Question: Produce a descriptive caption suitable for publication.
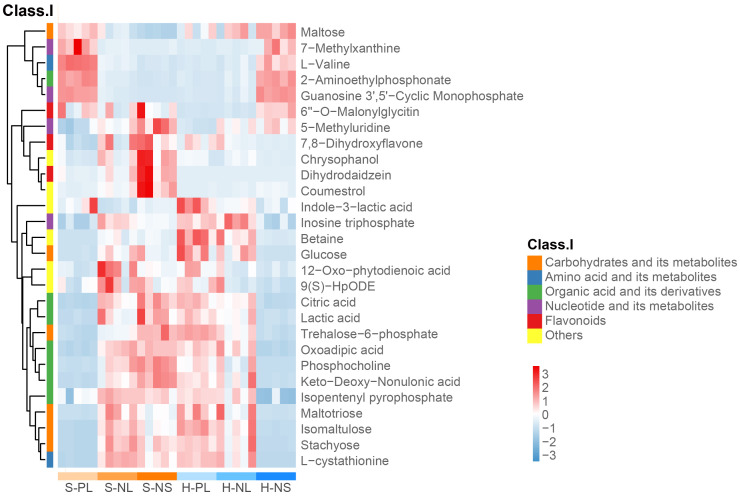
Answer: Clustered heatmap of differential metabolites under S3 salt treatment. S, Soybean; H, Suaeda salsa . PL, Plastic barrier separation; NL, Nylon mesh separation; NS, No separation.